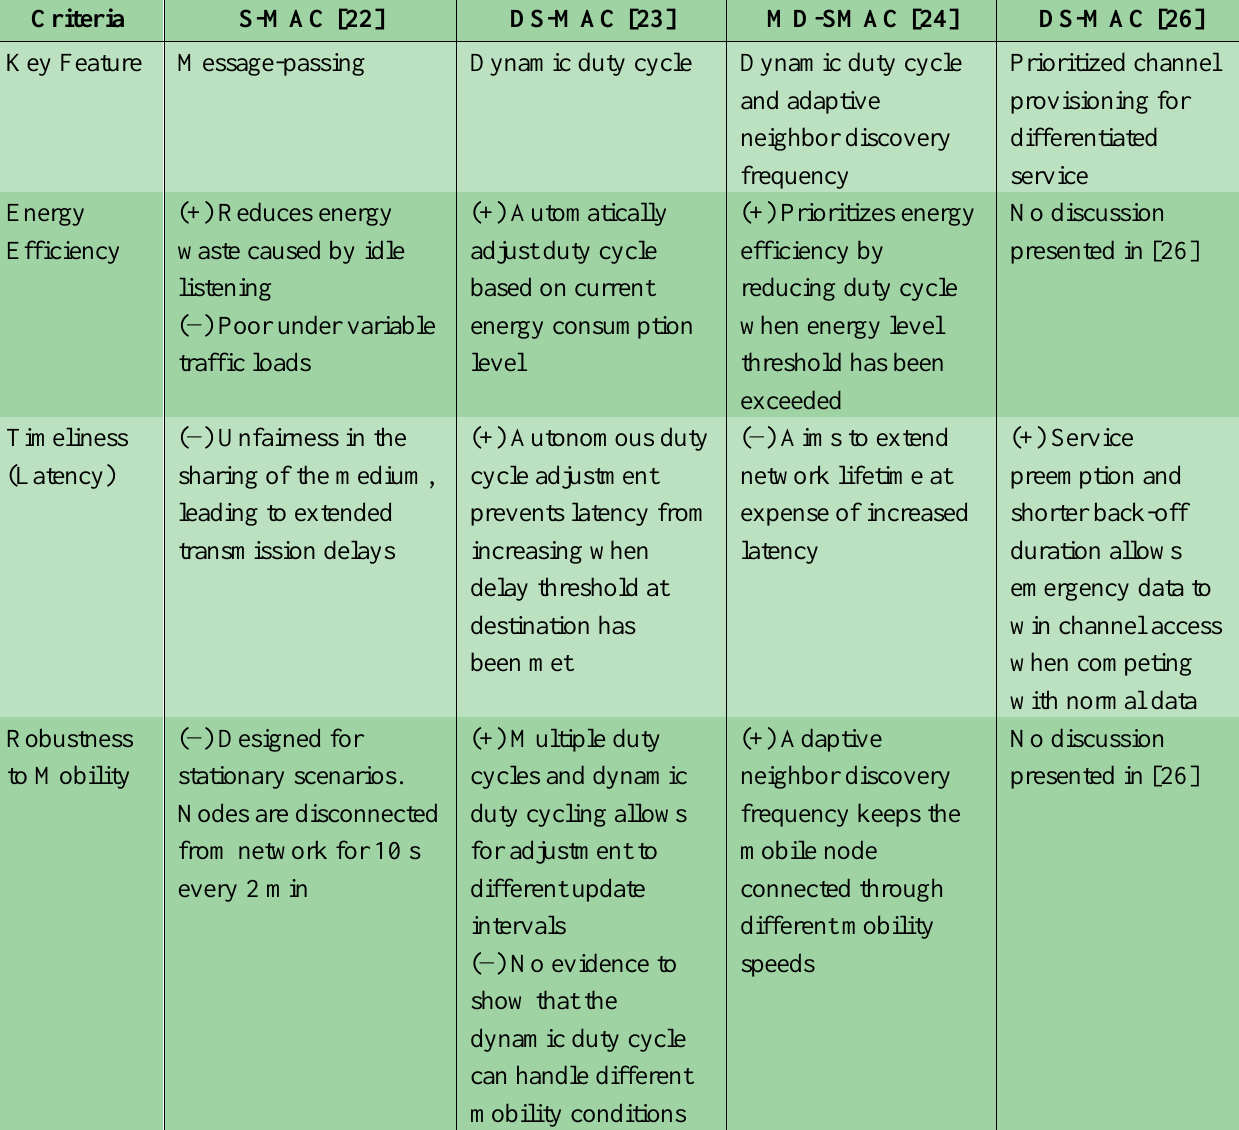
Table 2. Summary of potential CSMA-based protocols for